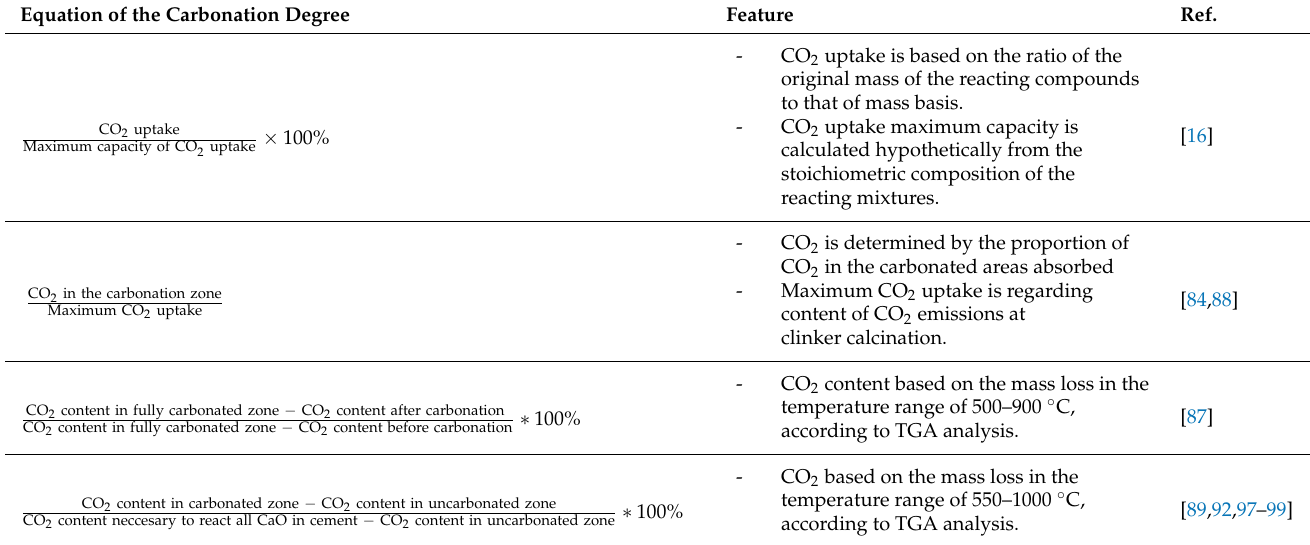
Table 2. Several mathematical models for carbonation degree calculation by means of CO 2 content. Equation of the Carbonation Degree Feature